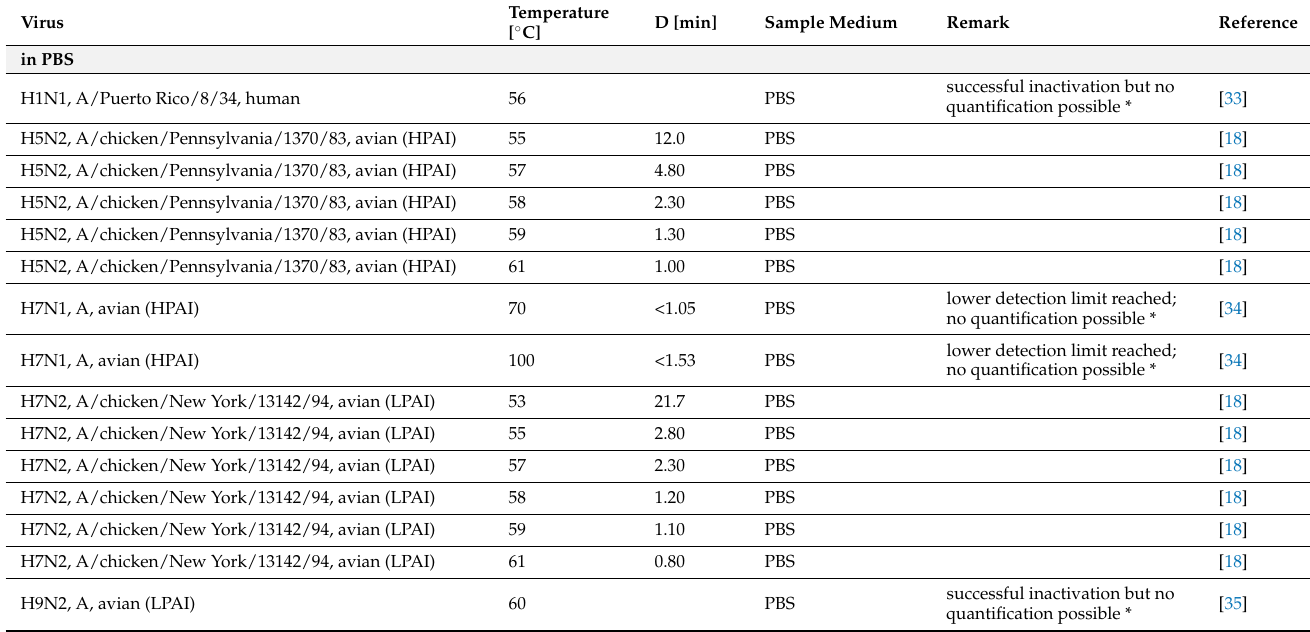
Table 1. Overview of published influenza virus thermal inactivation experiments with virus (sub- type), medium and determined decimal reduction time D(T). (* experiments were not included